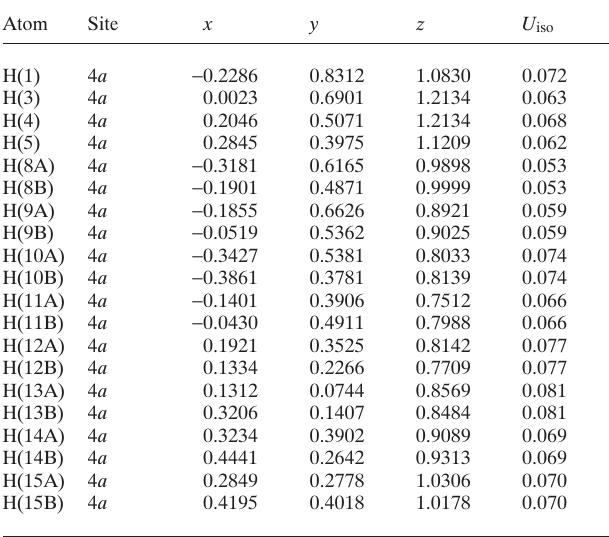
Table 2. Atomic coordinates and displacement parameters (in Å 2 )